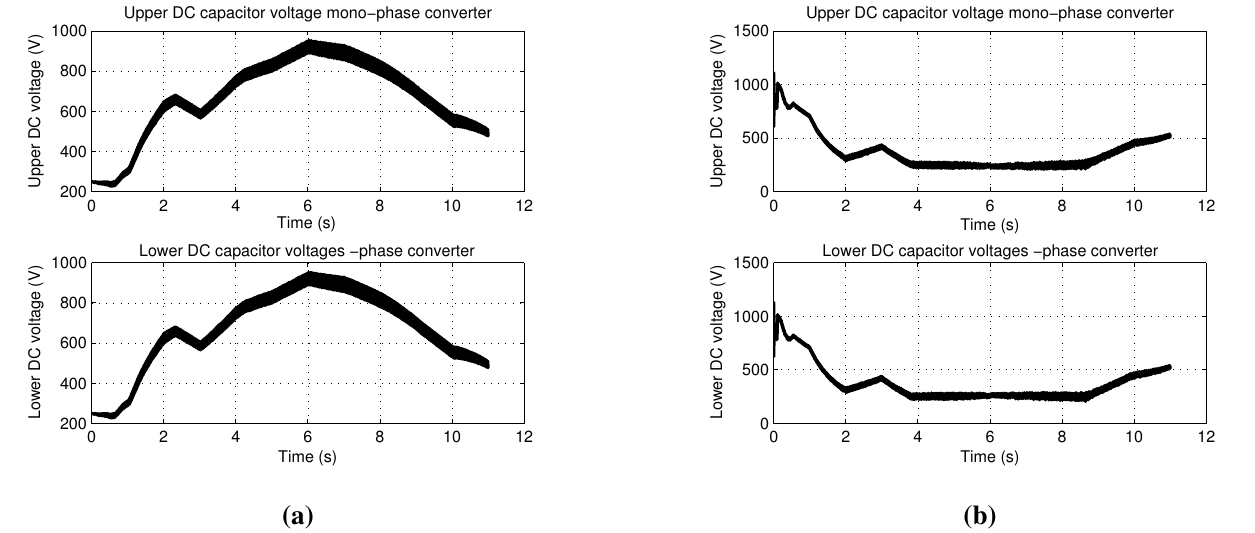
Figure 11. Capacitors’ voltage in the stochastic simulation. ( a ) Single-phase converter DC upper and lower capacitor voltage; ( b ) three-phase converter DC upper and lower capacitor voltage.